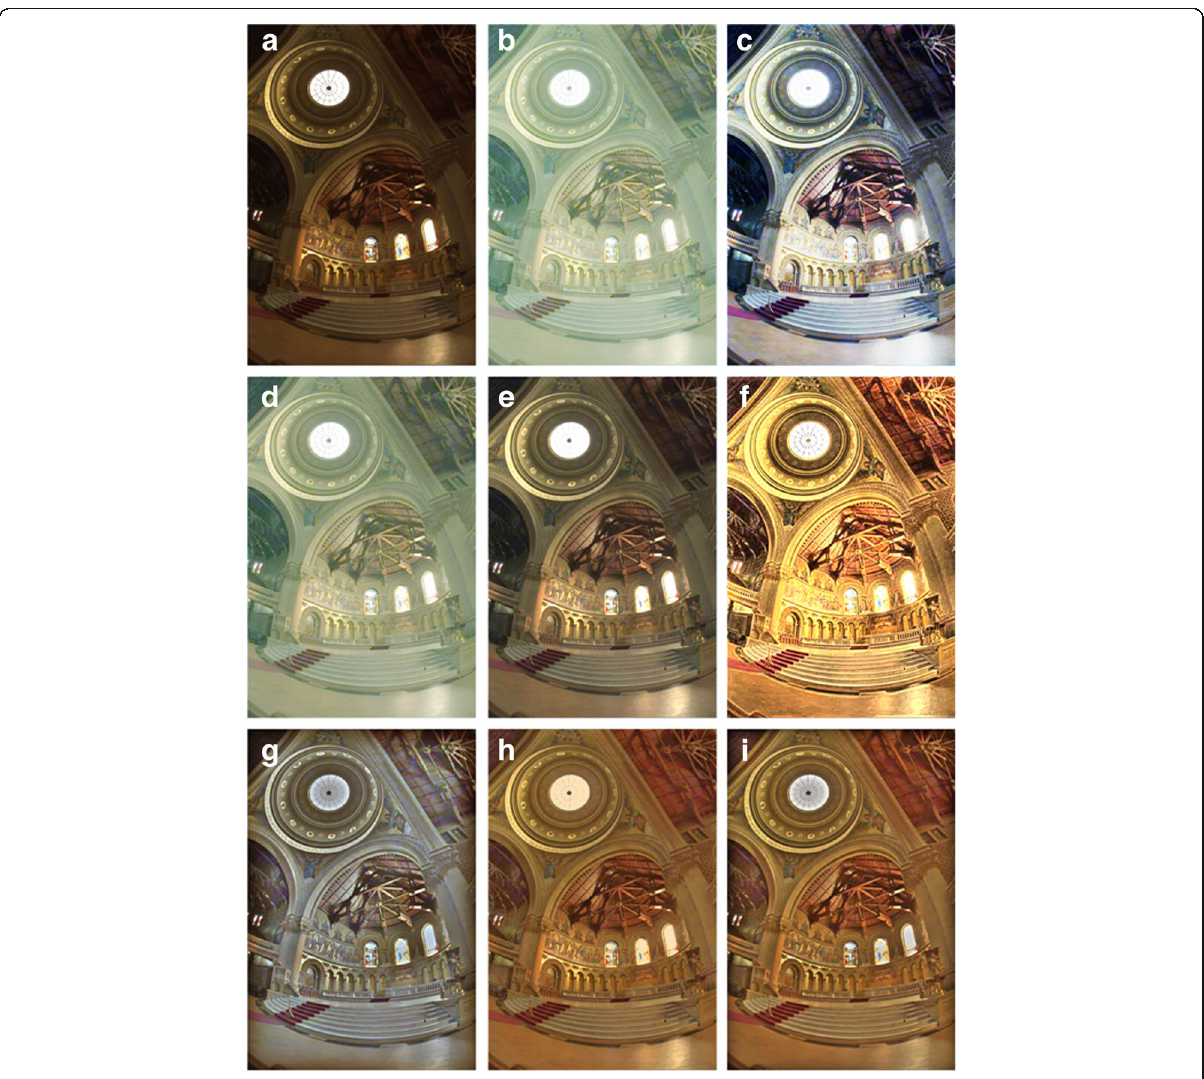
Fig. 3 Experimental results on church. a Original image; b MSR; c LHE; d AL; e ALTM; f GUM; g SARV; h NPE; i